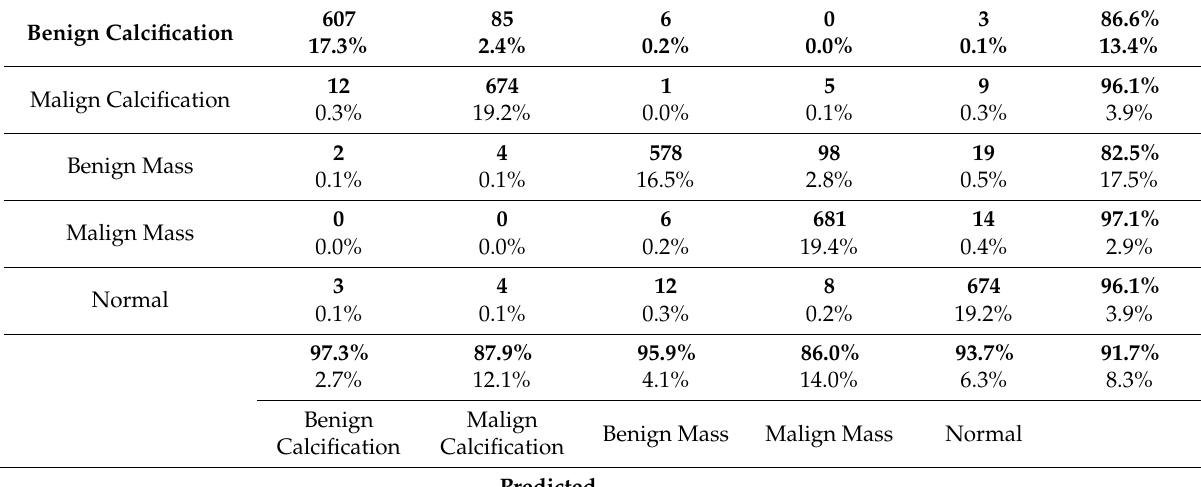
Table 5. Best confusion